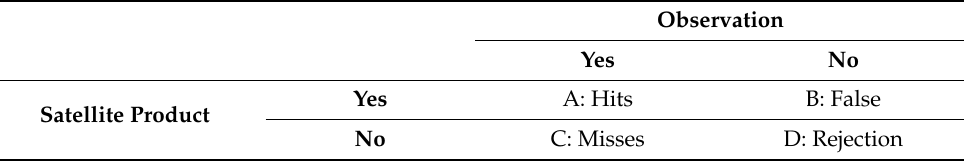
Table 4. Contingency table for categorical metrics. A: corresponds to an event detected by the satellite product and the rain gauge; B corresponds to an event detected only by the satellite product; C corresponds to an event detected by the rain gauge but not by the satellite product; D corresponds to an event not detected by the rain gauge nor by the satellite